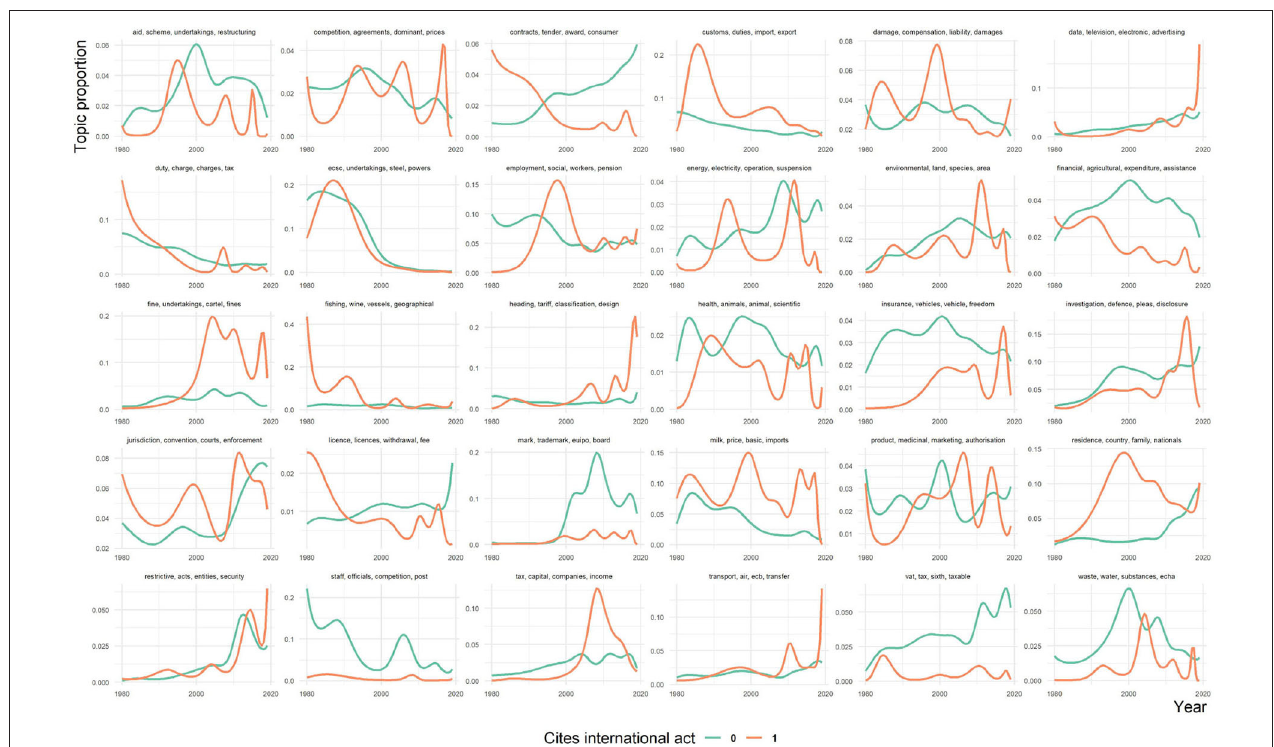
FIGURE 6 | Topic proportion in EU court cases (1980–2019) with and without reference to EU international agreements. Topics are summarized by their four most-characteristic words.